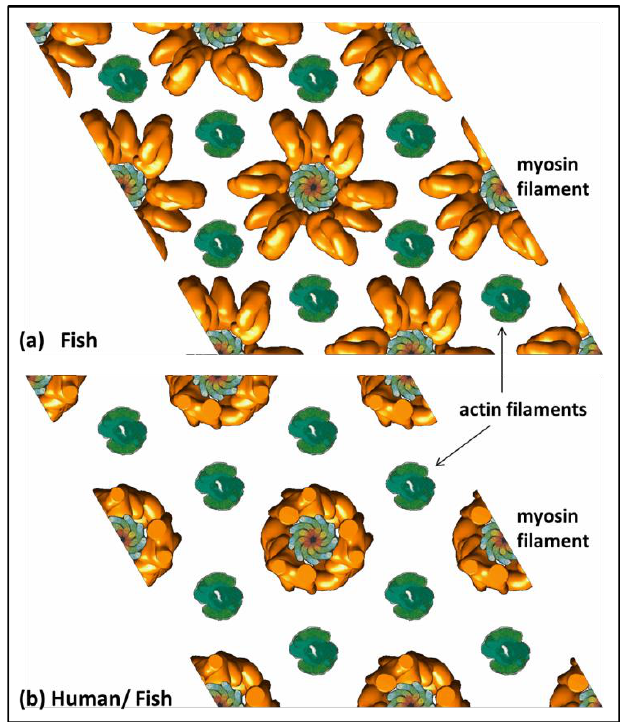
Figure 3. The fish muscle unit cell with the myosin filament head arrangements (dark yellow) from ( a ) Hudson et al. [10] and ( b ) as in human heart muscle (AL-Khayat et al. [25]). The myosin filament backbone structure is from Chew and Squire [30]. Actin filaments are shown in green.